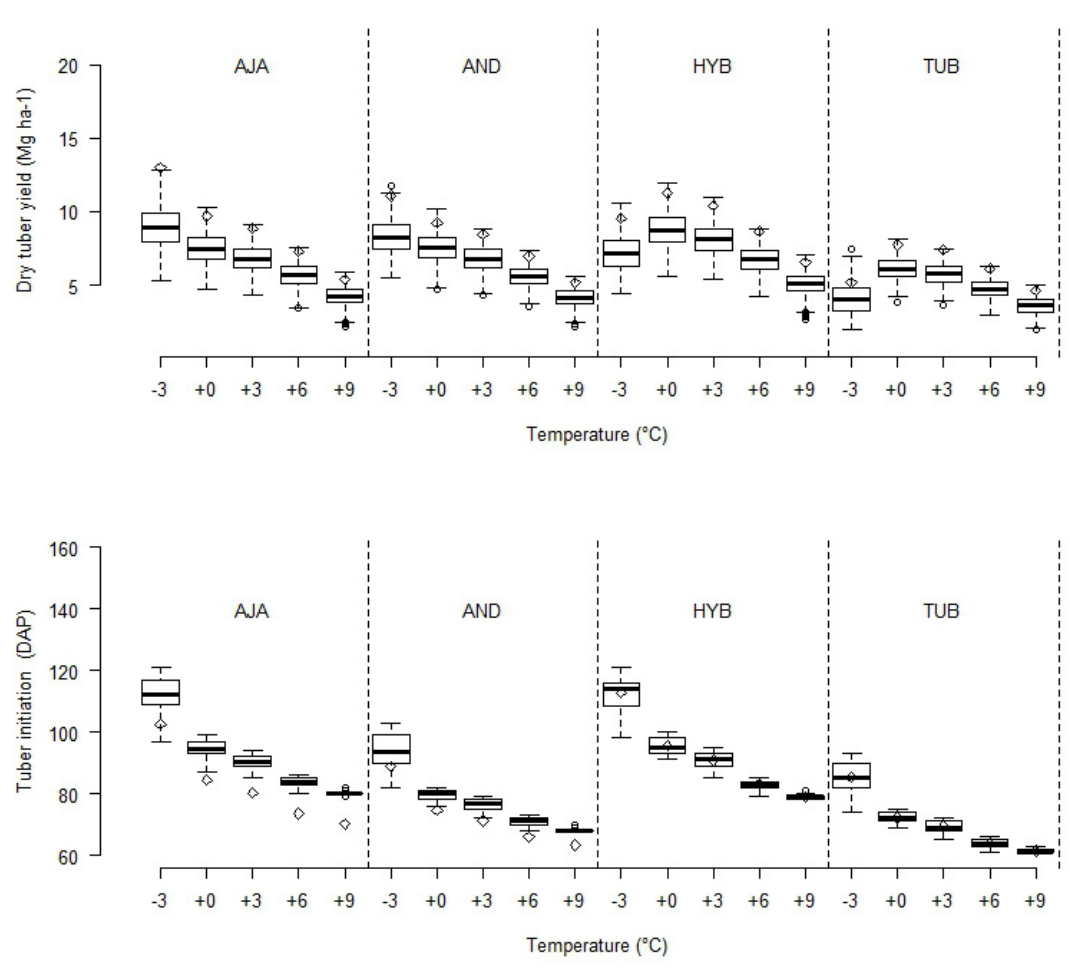
Figure 1: Air temperature effects on dry tuber yield (top) and tuber initiation (bottom) based on 30-year simulations of potato growth in the Andean Highlands under rainfed conditions for different genotypes; AJA: S. ajanhuiri , var. Ajanhuiri; AND: S. tuberosum ssp. andigenum, var. Waycha; HYB: S. tub ssp. tuberosum X S. tub ssp. andigenum, var. Sajama and TUB: S. tuberosum ssp. tuberosum, var. Alpha. Results